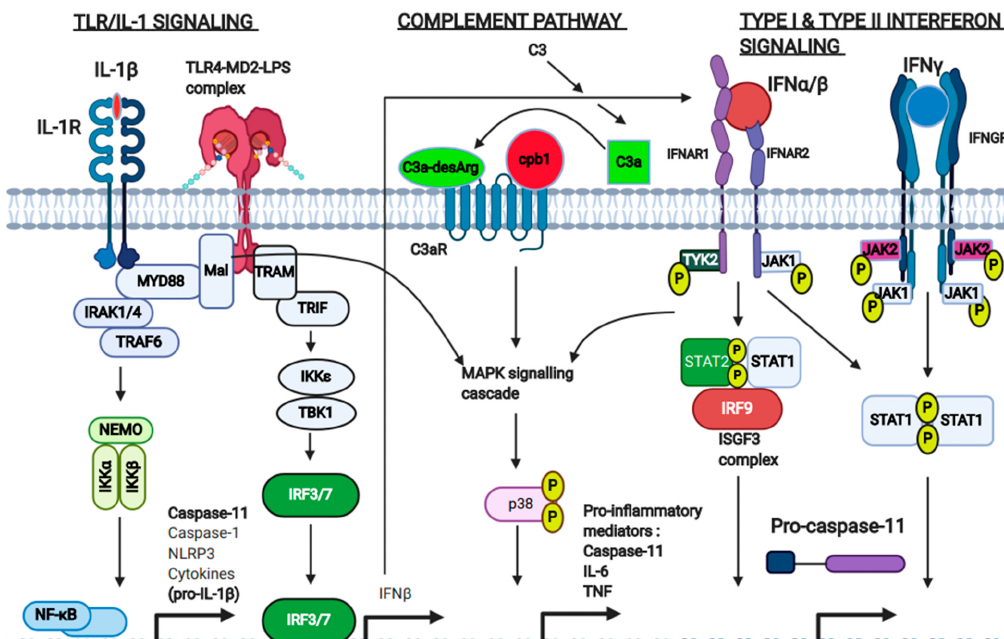
Figure 2. Caspase-11 upregulation occurs as a result of PAMP and/or cytokine signaling and can be amplified by complement signaling. TLR signaling—Exogenous PAMPs, such as LPS, that signal through TLRs result in MYD88-dependant activation of NF- κ B. Endocytosed LPS-TLR4 signals through the TRIF adaptor protein, resulting in the activation of IRF3 and IRF7 and activation of type I IFNs, which are responsible for caspase-11 upregulation downstream of LPS. IL-1 β signaling—IL-1 β signals through the IL-1 receptor complex, which results in MYD88-dependant NF- κ B activation and Type I IFN signaling. IL-1 β -mediated upregulation of caspase-11 is dependent on type I IFN-signaling. Type I IFN signaling—IFN α / β , which is also generated following LPS and IL-1 β stimulation, signals through IFNAR. This results in phosphorylation of STAT1/STAT2 and formation of the ISGF3 transcriptional complex, which significantly upregulates caspase-11. Caspase-11 upregulation via Type I IFNs, LPS, or IL-1 β is significantly impaired in Ifnar − / − BMDM, highlighting the importance of IFNAR signaling for caspase-11 expression. Type II IFN signaling—IFN γ signals through the IFNGR, resulting in the formation of a phospho-STAT1 dimer, which is capable of directly upregulating genes, such as caspase-11, which have IFN-stimulatory-gene (ISG) promoter sequences. Complement pathway—the complement protein cleavage product, C3a, is modified to C3a-desArg by the carboxypeptdidase Cpb1, which is associated with the C3a receptor (C3aR). The modified cleavage product then signals through C3aR, resulting in downstream activation of the MAPK pathway. This pathway acts to amplify p38 activation downstream of TLR4 and IFNAR signaling, boosting caspase-11